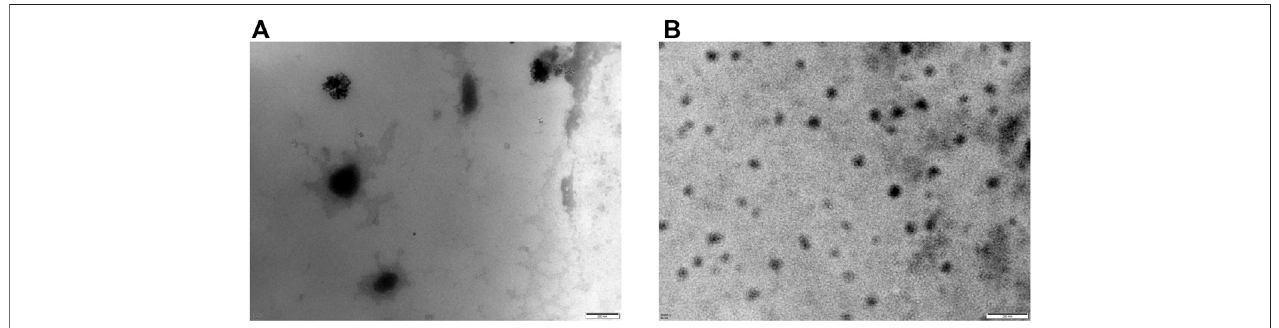
FIGURE 5 | Transmission electron microscopy (TEM) images of micelles: DSPE-PEG-C60: DOX = 10:1 (W/W) (A) and DSPE-PEG-NH 2 : DOX = 10:1 (W/W) (B) .